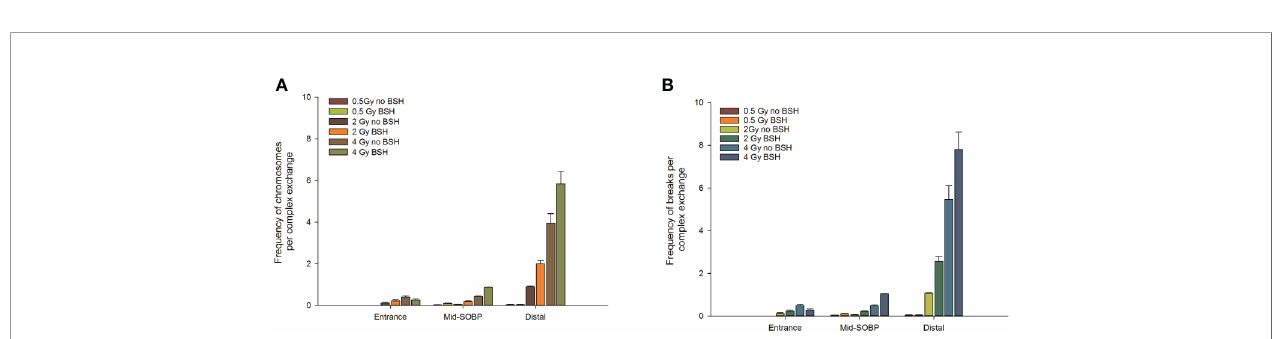
FIGURE 4 | Frequency of complex-type aberrations as revealed by WCP, left panel (A) , or by mFISH, right panel (B) , as a function of dose and position along the INFN-LNS proton beam SOBP for samples irradiated in the presence or absence of BSH. Data from previous experiments (14) obtained for mid-SOBP are also presented for comparison. Error bars depict SE of the mean from at least three